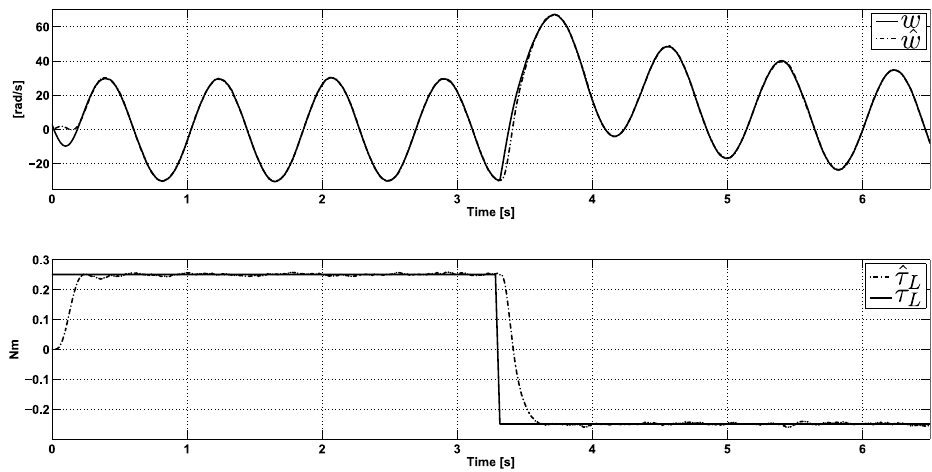
Figure 1. Open-loop estimation of w and τ L with u fixed as in